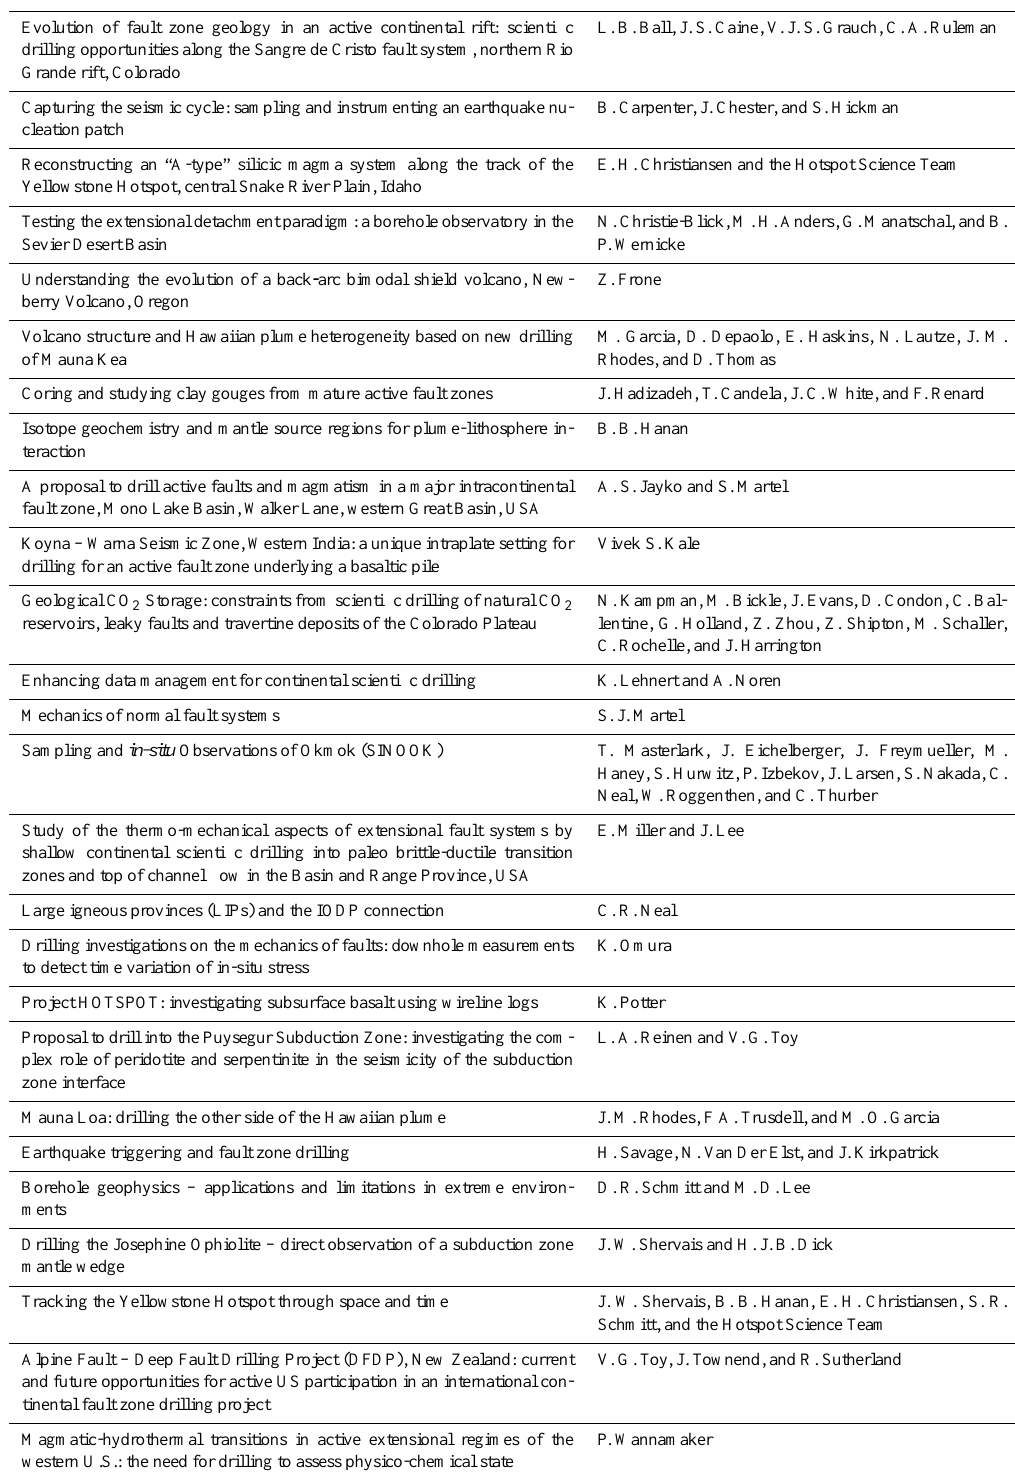
Table 1. List of white papers prepared for the workshop, and published through USU Digital Commons portal: http://digitalcommons.usu.